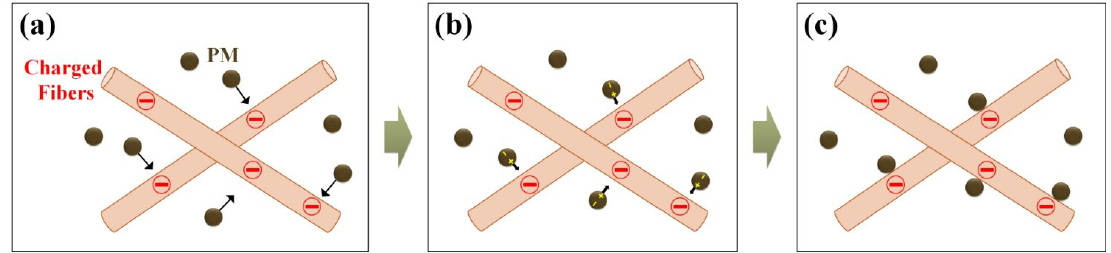
Figure 3. Tapping-mode piezoelectric output voltages of ( a ) membranes and ( b ) p-membranes.